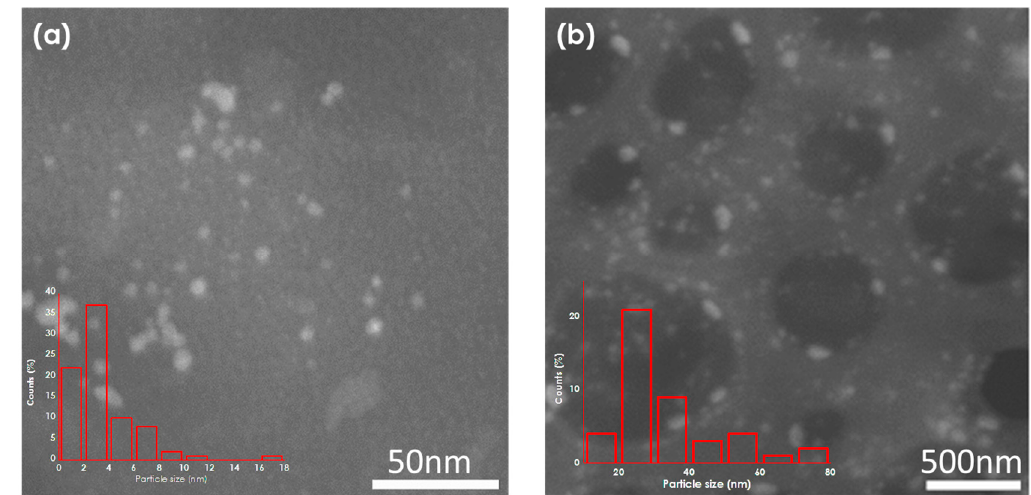
Figure 6. Temporal H 2 evolution upon reuse of Pd/CS catalyst either fresh or reused (once or two) catalyst. Reaction conditions: 10 mmol of ammonium formate, 10 mL of methanol, 60 °C, and 11.75 µmol of Pd.